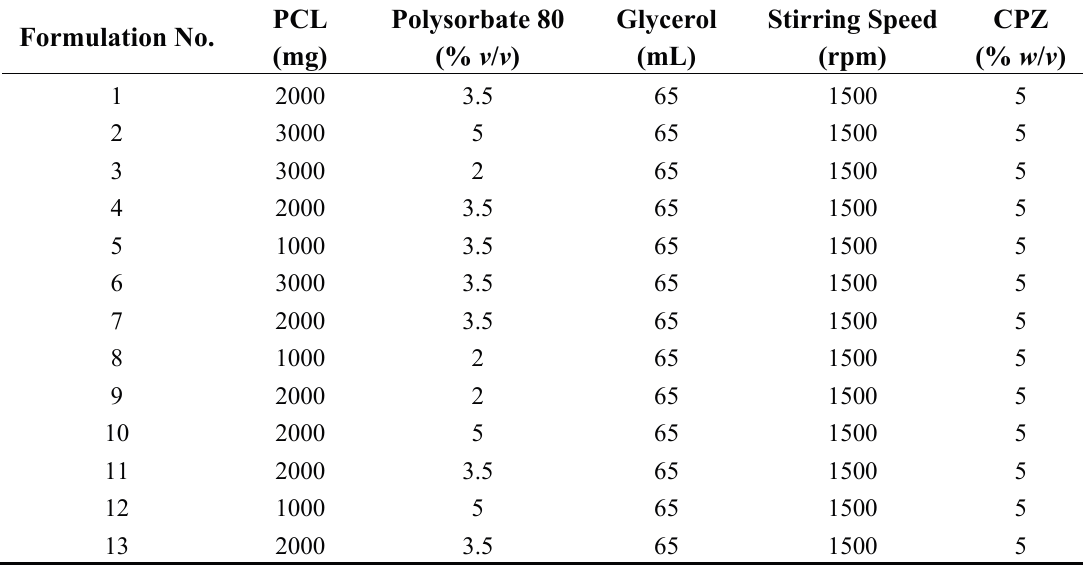
Table 1. Face-centered central composite design template with statistically generated formulations. Formulation No.